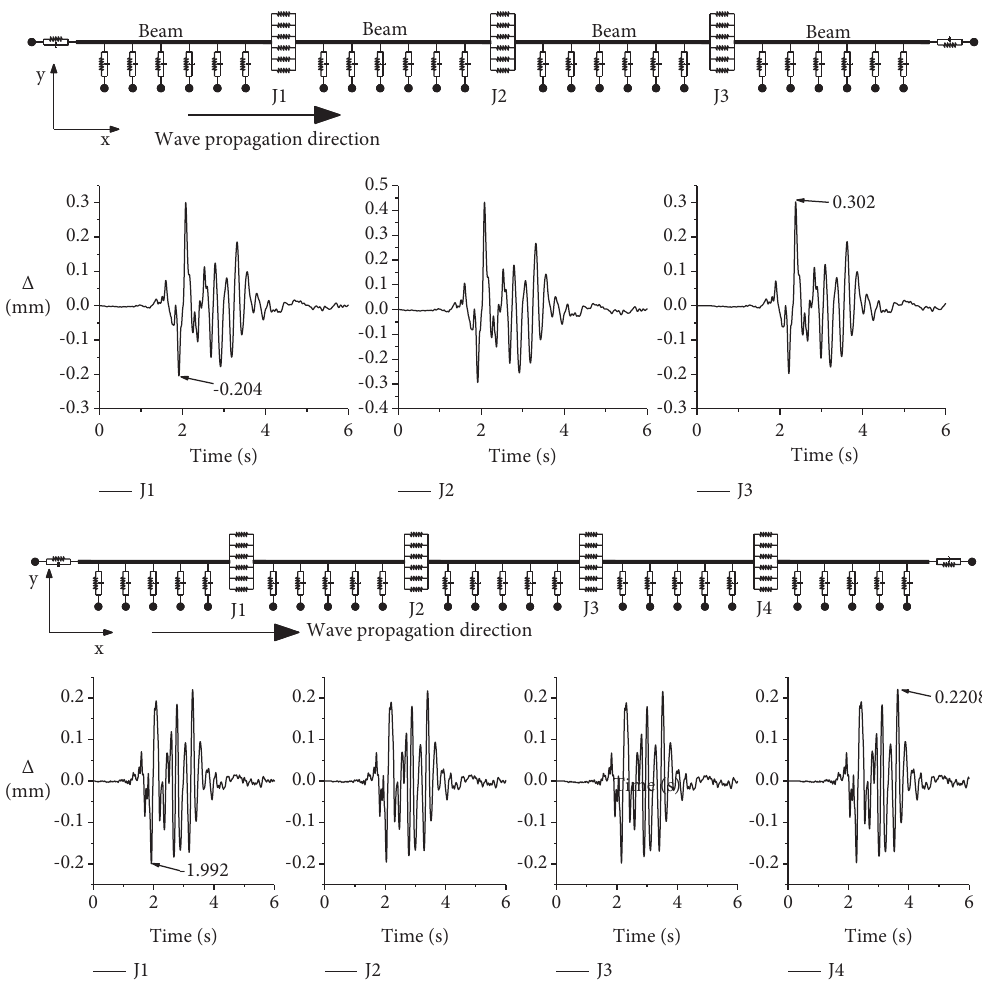
Figure 24: Deformation time history curves of each